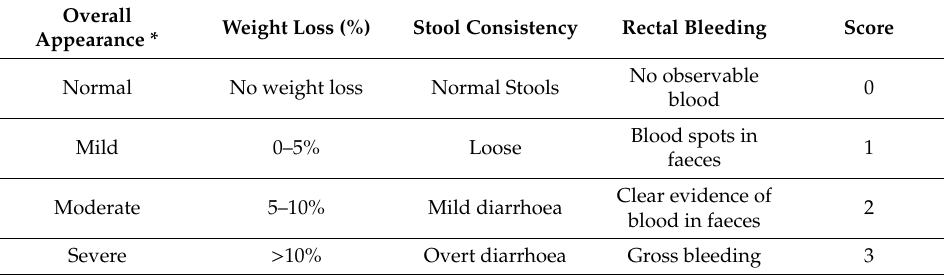
Table 1. Disease activity index scoring